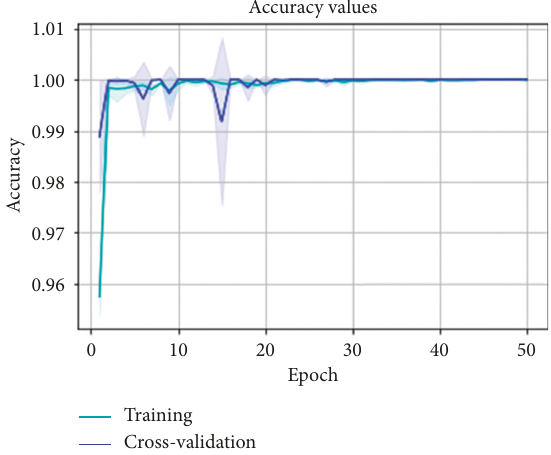
Figure 5: Accuracy rate of training data set.